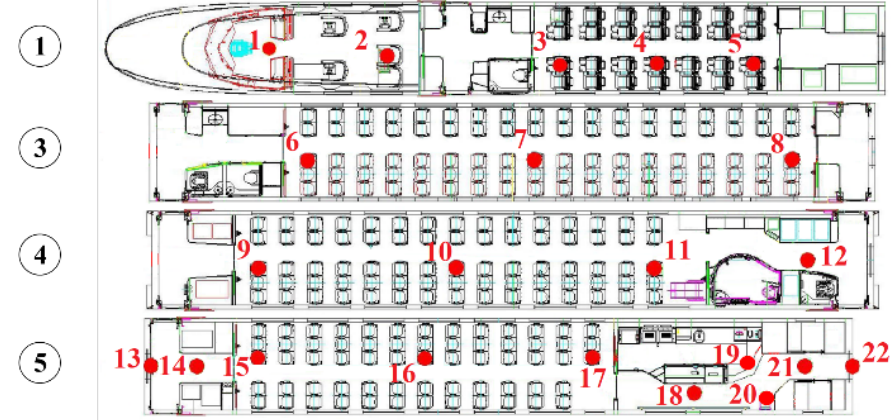
Figure 2. Twenty-two measuring points (Red numbers) in carriages 1, 3, 4, 5.